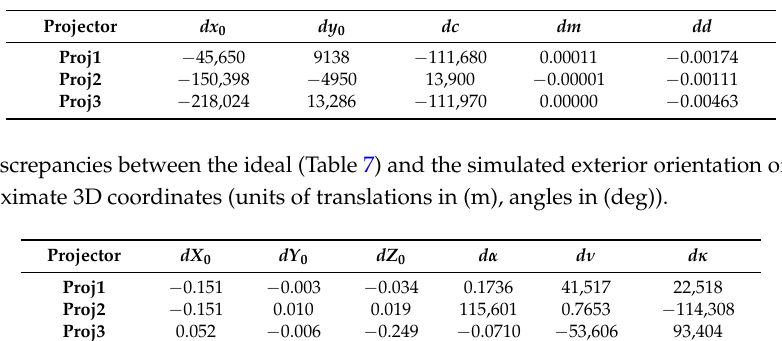
Table 8. Discrepancies between the ideal (Table 6) and the simulated projector interior orientation with approximate 3D coordinates (units in (pixels) for x 0 , y 0 and c ).